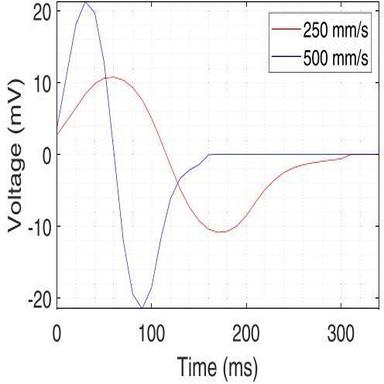
Voltage vs time for 5 turns at different speeds.